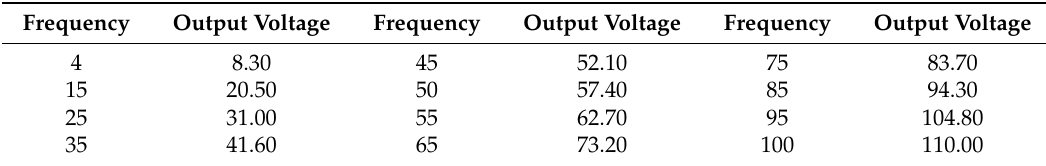
Table 1. Relationship between frequency and voltage of output signals of coil (Frequency: Hz; Output voltage: mV).